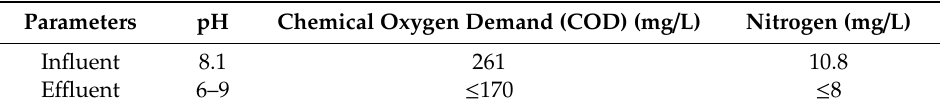
Table 1. Required influent and effluent parameters.